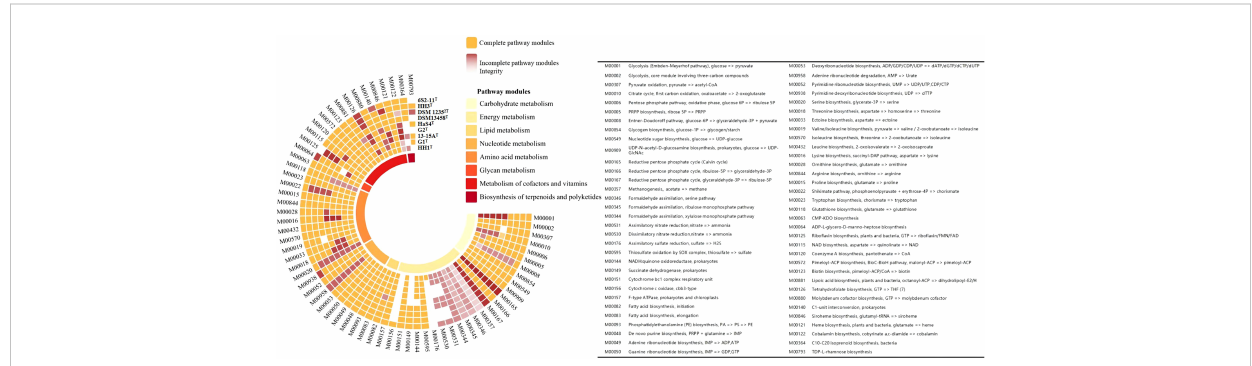
FIGURE 3 The metabolic modules integrity of Thiomicrorhabdus strains. The orange color blocks represent intact metabolic modules, and the red-brown color blocks represent incomplete metabolic modules. The integrity of incomplete metabolic modules is indicated by color shades. The lowest integrity is 0 for white.